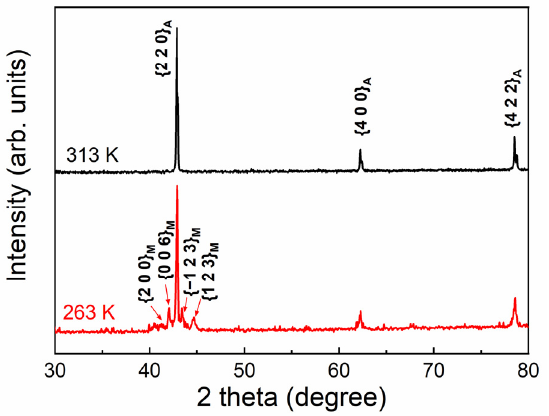
Figure 2. Powder XRD patterns measured at 313 K and 263 K for the directionally solidified Ni 44.5 Co 4.9 Mn 37.5 In 13.1 alloy.